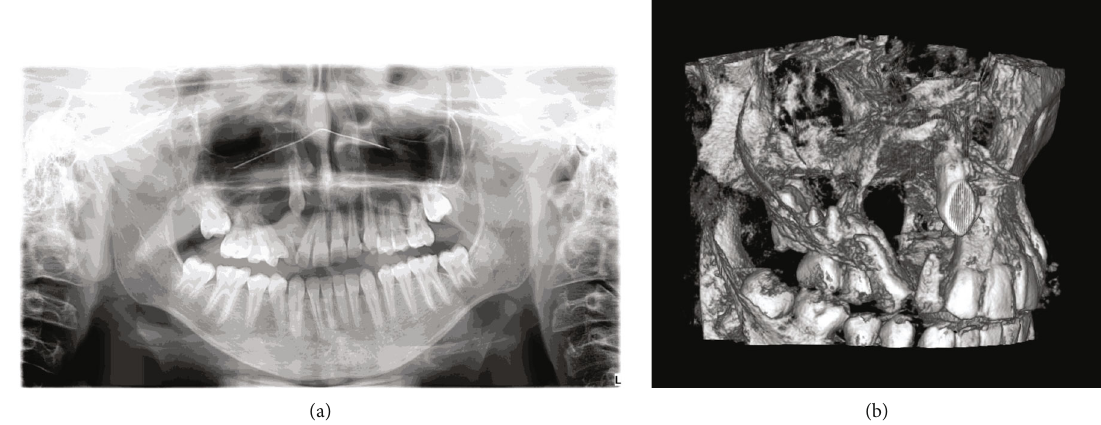
Figure 1: OPG (a) and CBCT 3D scan (b). A considerable size of the lesion and translocation of tooth 13 are visible (arrow).